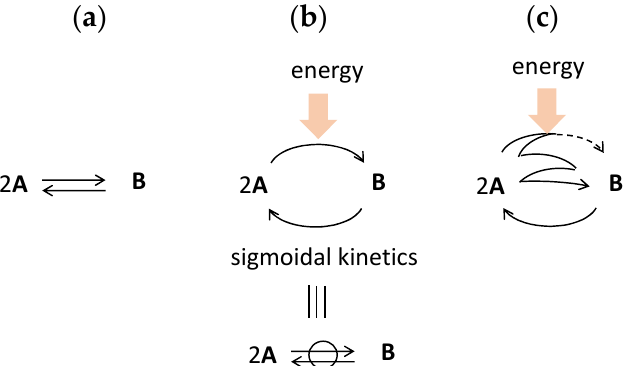
Figure 8. ( a ) Ordinary competitive chemical reactions 2 A → B and 2 A → C , and ( b ) reversible com- petitive chemical reactions B 2 A C involving self-catalytic chemical reactions 2 A + B → 2 B and 2 A + C → 2 C (red square), which are compared with chemical reaction 2 A → B .